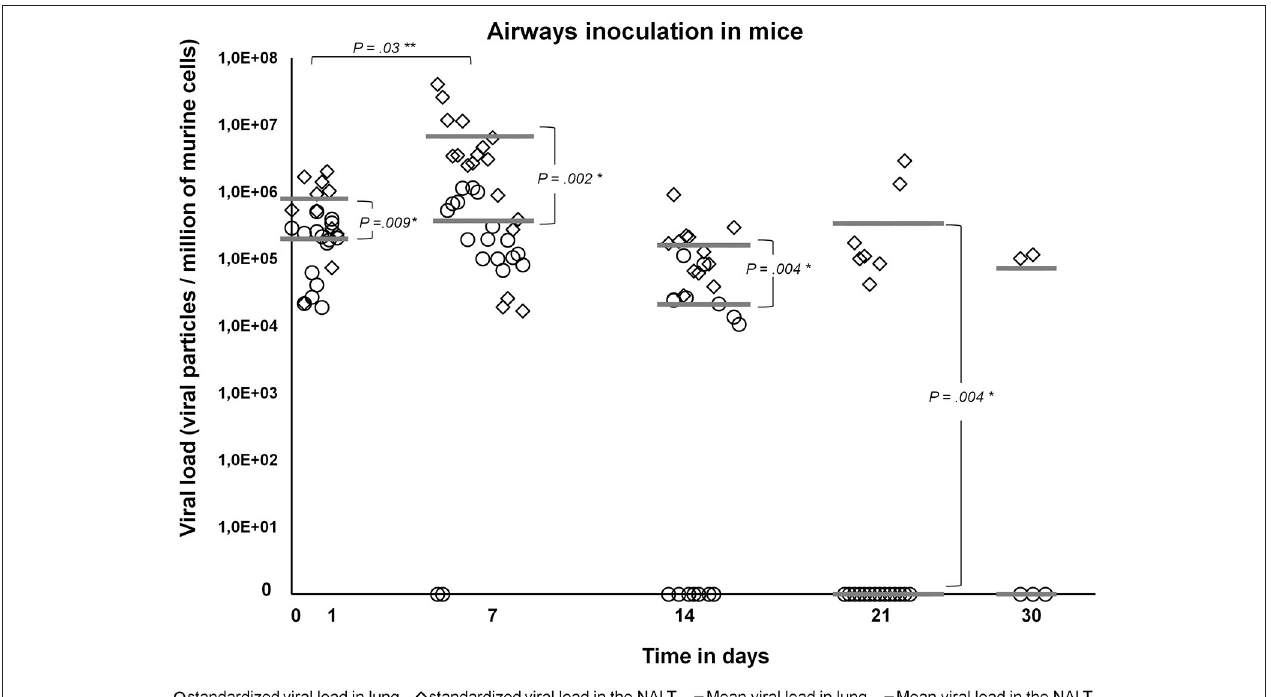
FIGURE 5 | Standardized viral loads (viral copies per million murine cells) in the lungs and the NALT of aerosol-inoculated mice by Marseillevirus suspension. Diamonds represent the viral loads in the NALT and circles represent the viral loads in the lungs for each animal. The mean viral loads are represented for each time point by thick dashes. The viral loads in lungs and NALT, and at different time points were compared by using Wilcoxon-Mann Whitney test, using sigmaplot 13 SYSTAT software Inc. software. Single asterisks show the time points with significant differences between NALT and lung viral loads. Double asterisks show significant differences between the NALT viral loads at different time